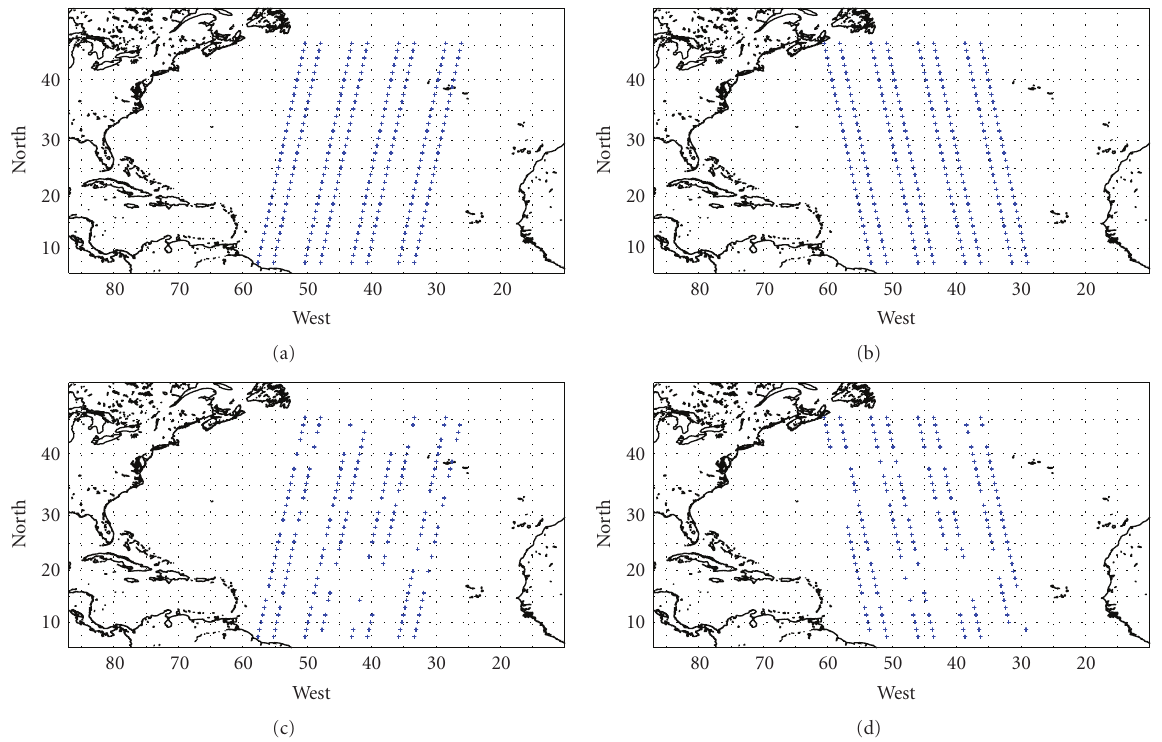
Figure 1: Simulated DWL observation locations at 0600 UTC ((a) and (c)) and 1800 UTC 01 October 2005 ((b) and (d)). (a), (b), (c), and (d) are simulated observation sampling for data assimilation Experiment 1 and Experiment 2,